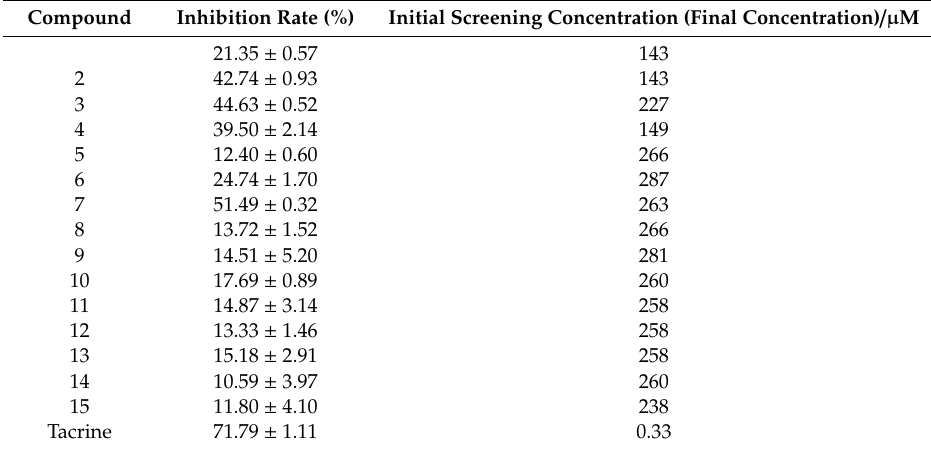
Table 3. The inhibitory activity of compounds 1 – 15 against AChE.